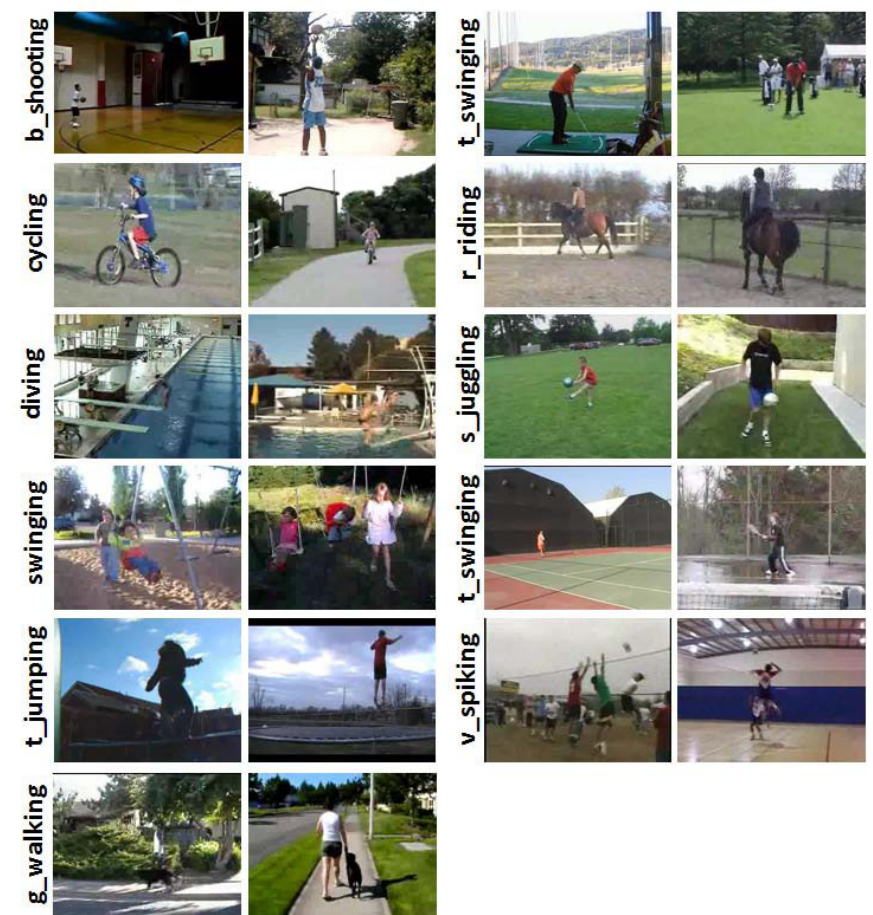
Figure 3. Illustration of the sample frames from video clips for all the 11 human action classes in the Youtube dataset [15]. (Note: the image is best viewed in